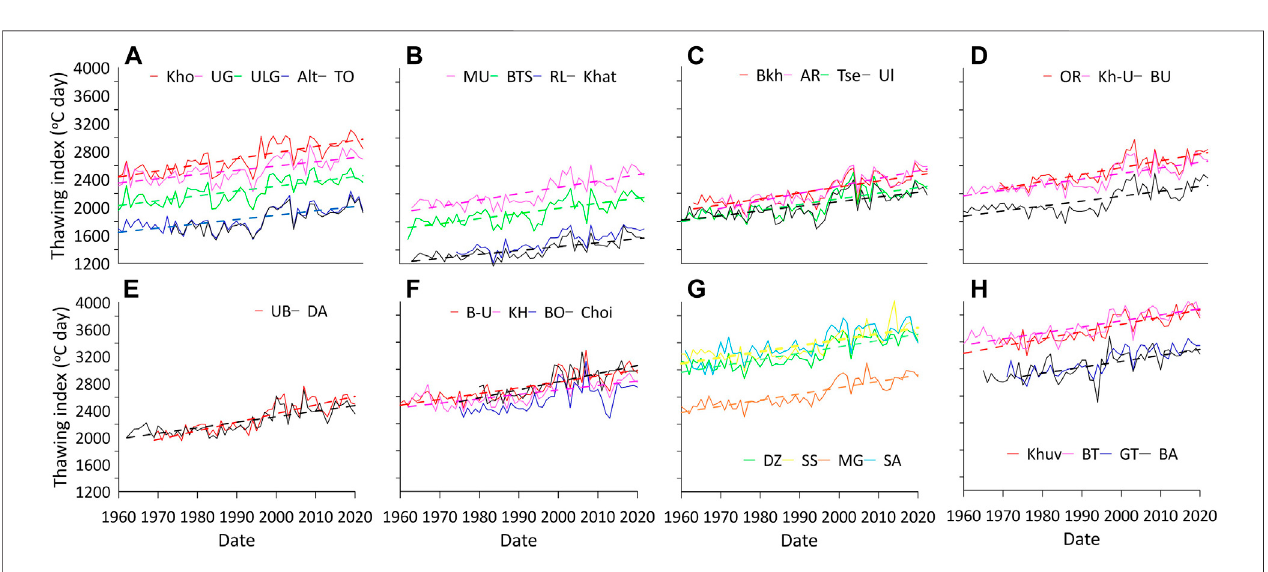
FIGURE 4 | Thawing index for 30 meteorological stations: (A) Altai mountains, (B) Khuvsgul Mountains, (C) Khangai mountains, (D) Orkhon and Selenge river valleys, (E) Khentii mountains, (F) Dornod steppe, (G) Gobi zone, and (H) Desert zone, respectively. The dashed lines show the linear trends, with colors matching the time series.